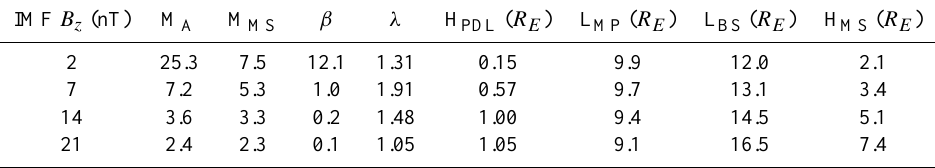
Table 4. The dependence of some important parameters on the IMF B z along the Sun-Earth line. IMF B z (nT) M A M